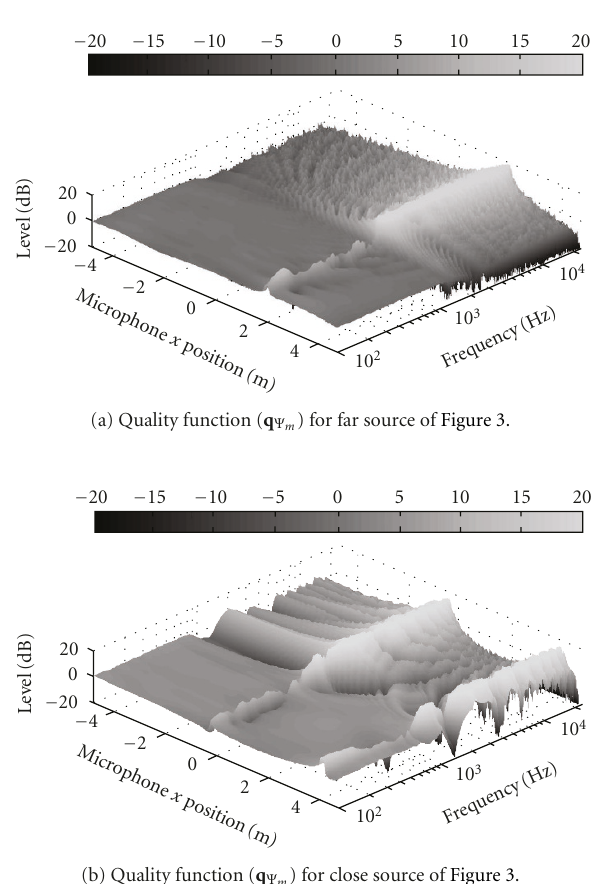
Figure 9: Frequency responses ( w Ψ of an 8m, 48-channel, loudspeaker array simulated on a line at 2m from the loudspeaker array for synthesis of the two sources displayed in Figure 3. Filters are calculated using the multichannel equalization method.